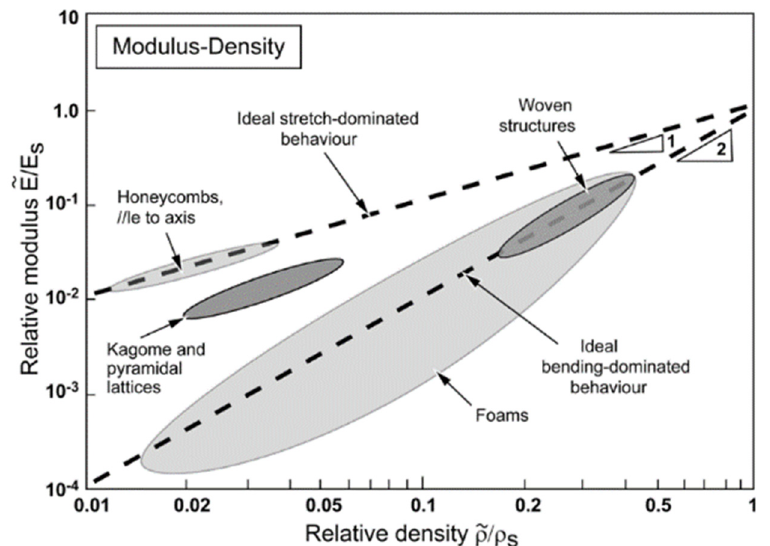
Figure 2. Plots of relative modulus vs. relative density in logarithmic scales for lattice structure [11].